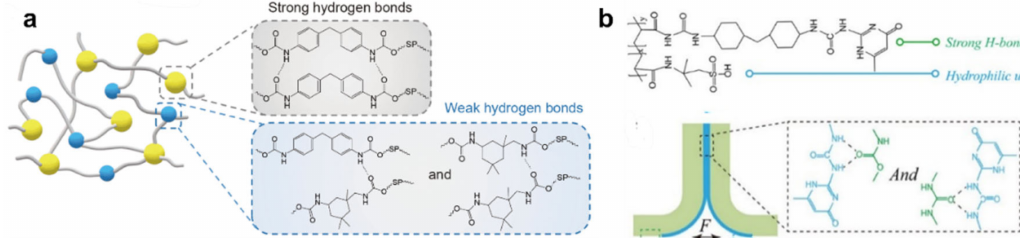
Figure 8. ( a ) Chemical structure of PDMS elastomer and associated conductive morphology diagram. Reproduced from [125] with permission from Springer Nature. ( b ) Scheme of TENG and H-bond at the interface. Reprinted with permission from [126]. Copyright (2020) American Chemical